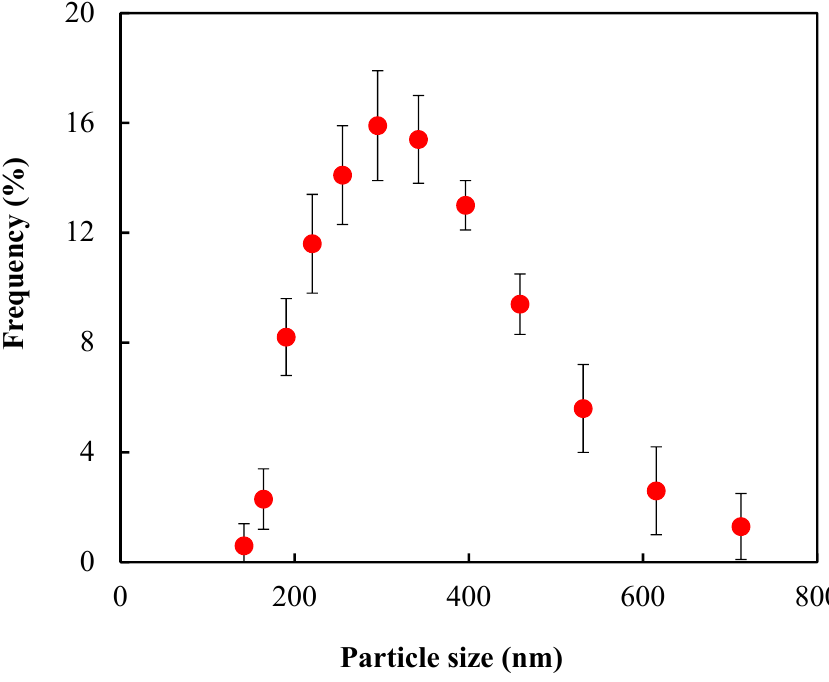
Figure 3. Size distribution of silicone nanoparticles obtained from DLS.